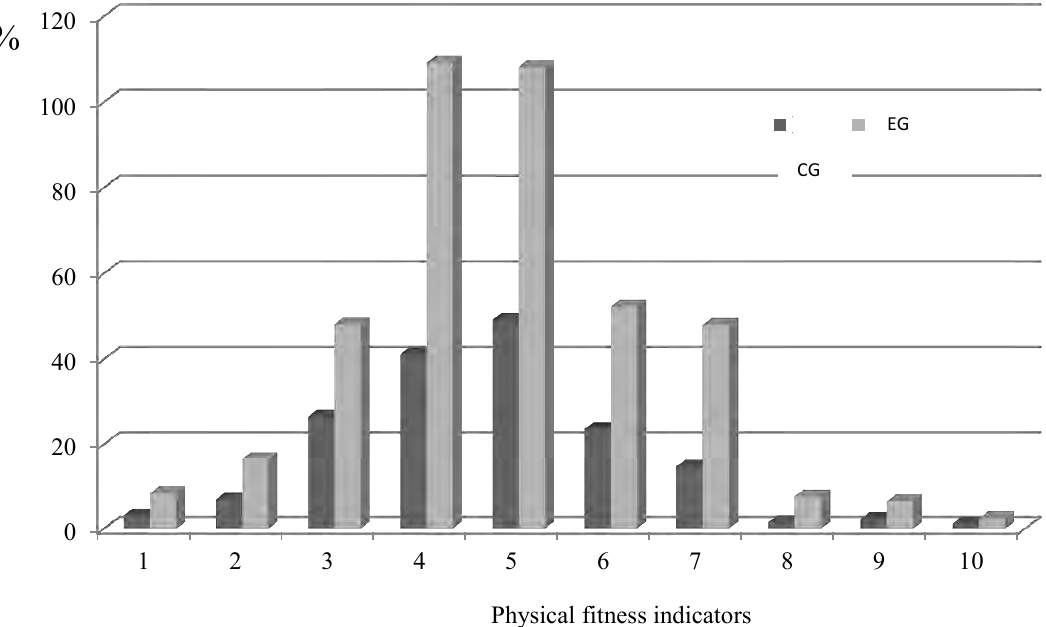
Fig.1. Increment of physical fitness indicators of 1 st group pupils (n=25) and 2 nd group (n=24) in the period of pedagogic